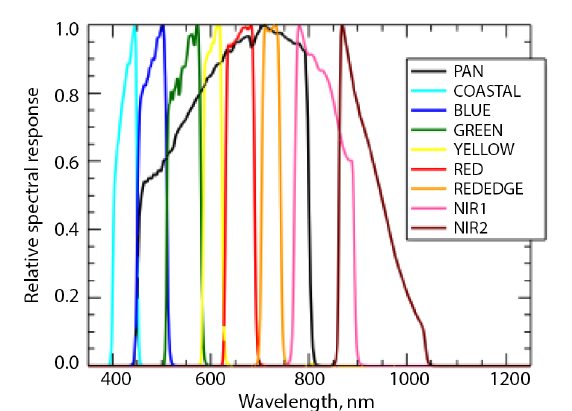
Figure 2. Worldview-3 spectral radiance response for the visible and near-infrared (VNIR) bands (source: http://worldview3.digitalglobe.com/)